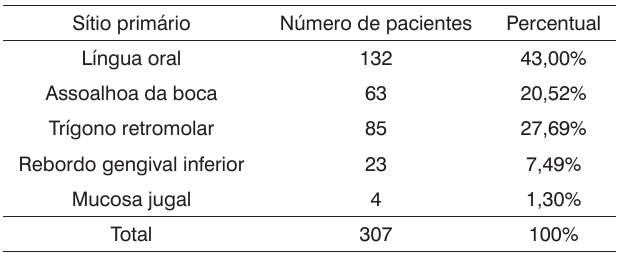
Tabela 4. Análise multivariada por regressão logística dos fatores de risco para metástases em níveis IV/V.